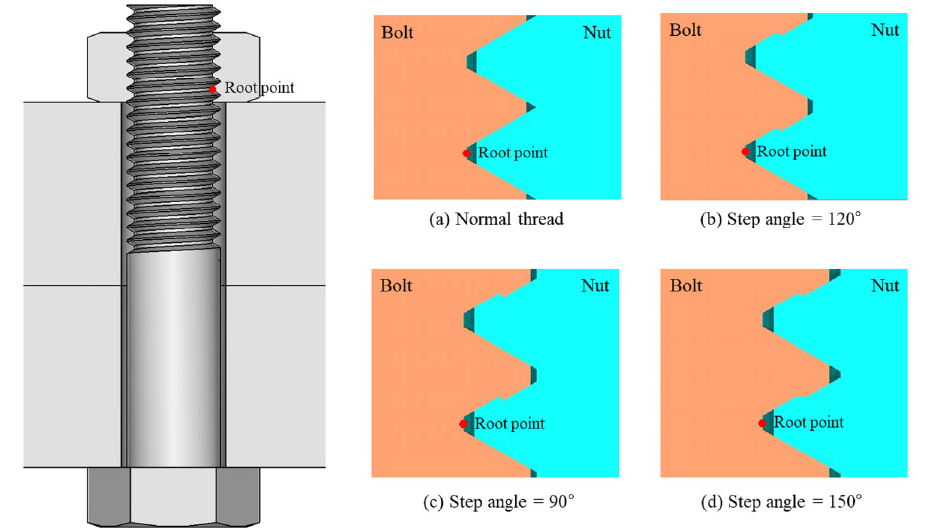
Fig. 13 Root points of the first engaged thread in the regular bolt and novel bolts with different step